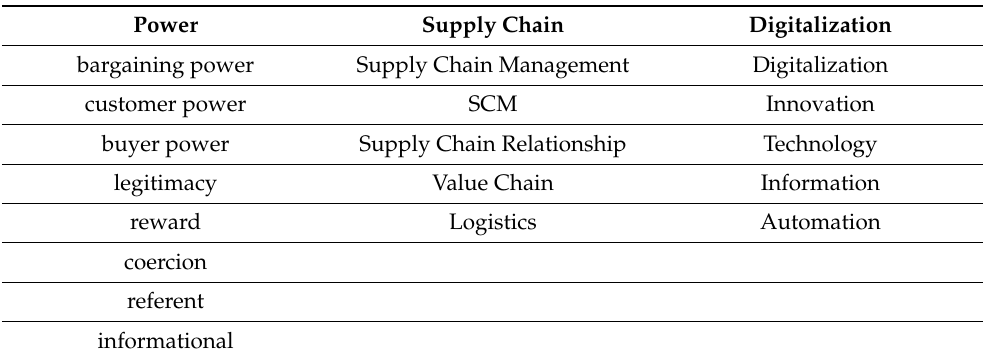
Table 1. Definition of the search terms.